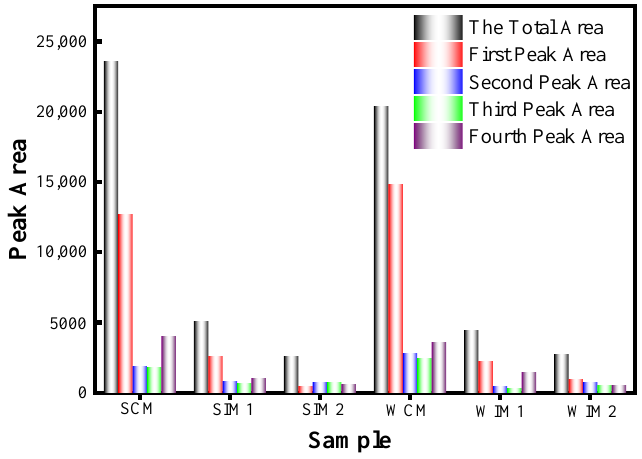
Figure 13. Peak areas of the sample. The “chemical effect” of IOT on pores can be indirectly assessed from the perspective of curing age. Figure 14 shows the T 2 spectra of the mortar specimens with the same IOT substitution rate at different ages.